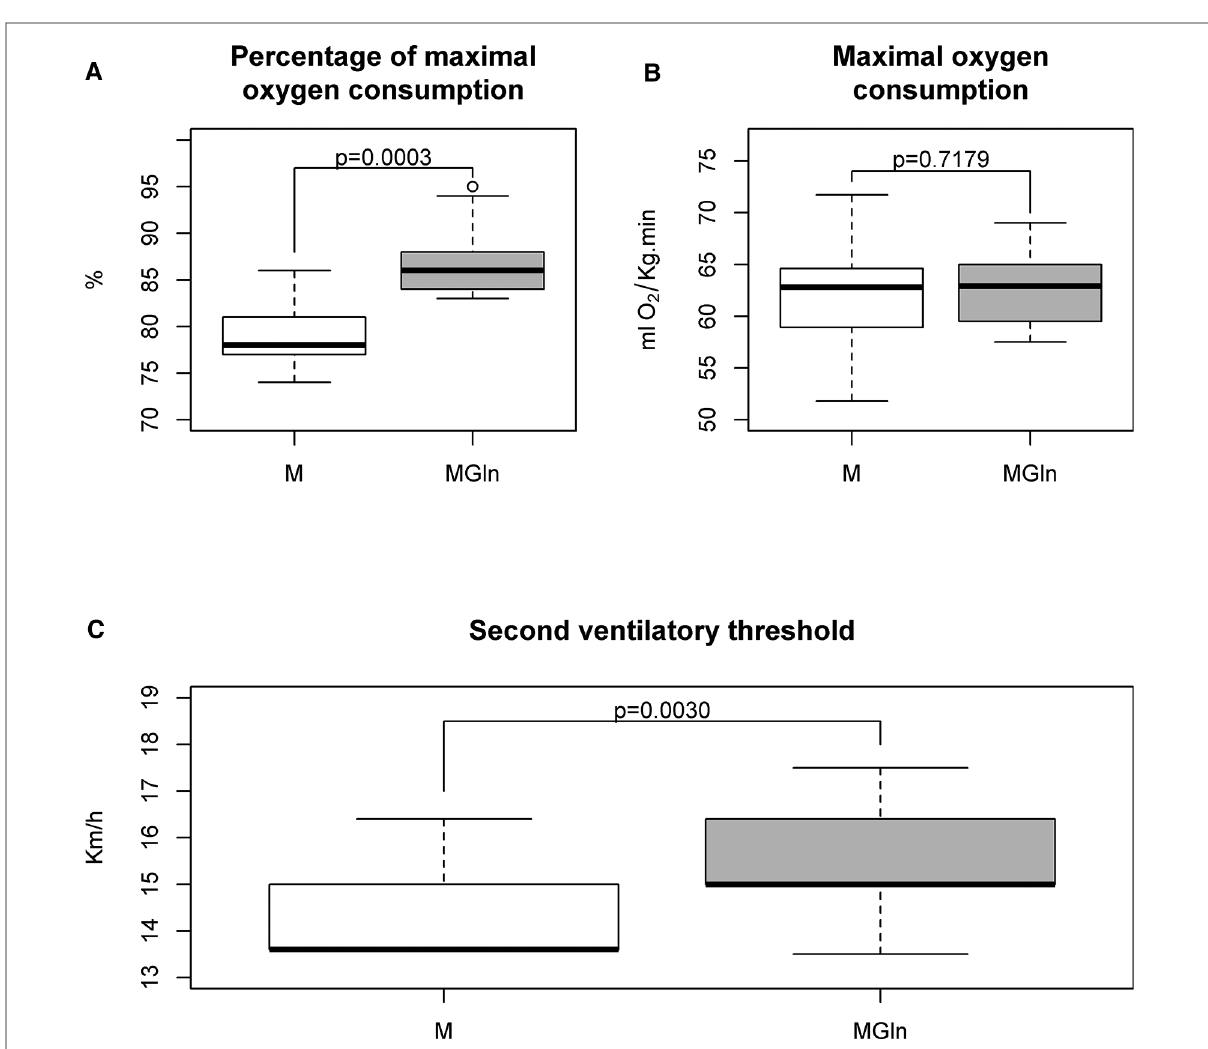
FIGURE 1 Cardiopulmonary testing in athletes supplemented with maltodextrin (M) or maltodextrin plus hydrolyzed protein enriched with glutamine (MGln). Percentage of maximal oxygen consumption ( A ), maximal oxygen consumption ( B ), and second ventilatory threshold ( C ) from athletes supplemented with M or MGln. For both tests, a signi fi cance level of 0.05 was